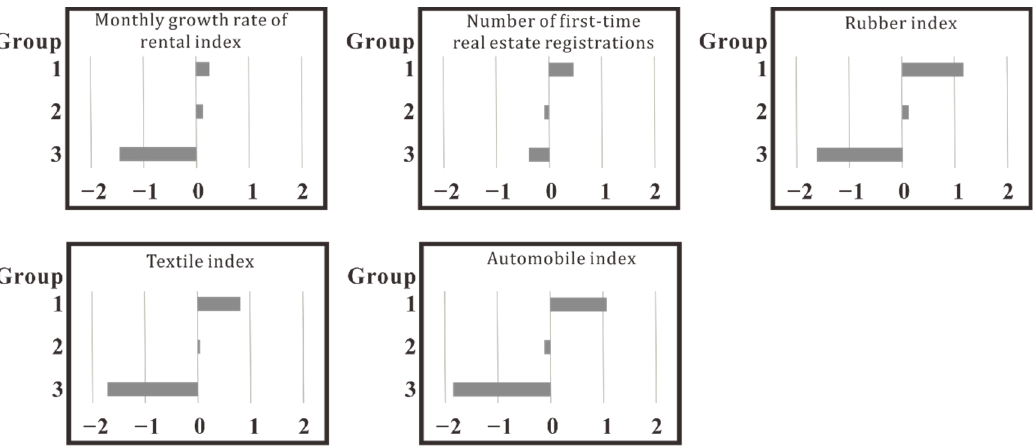
Figure 4. Average value of character in the monthly clustering result is related to the rental group.